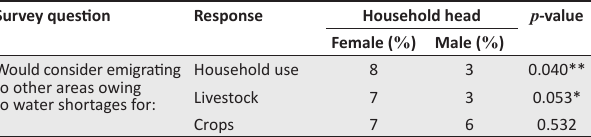
TABLE 5: Possibility of emigrating to other areas owing to future water